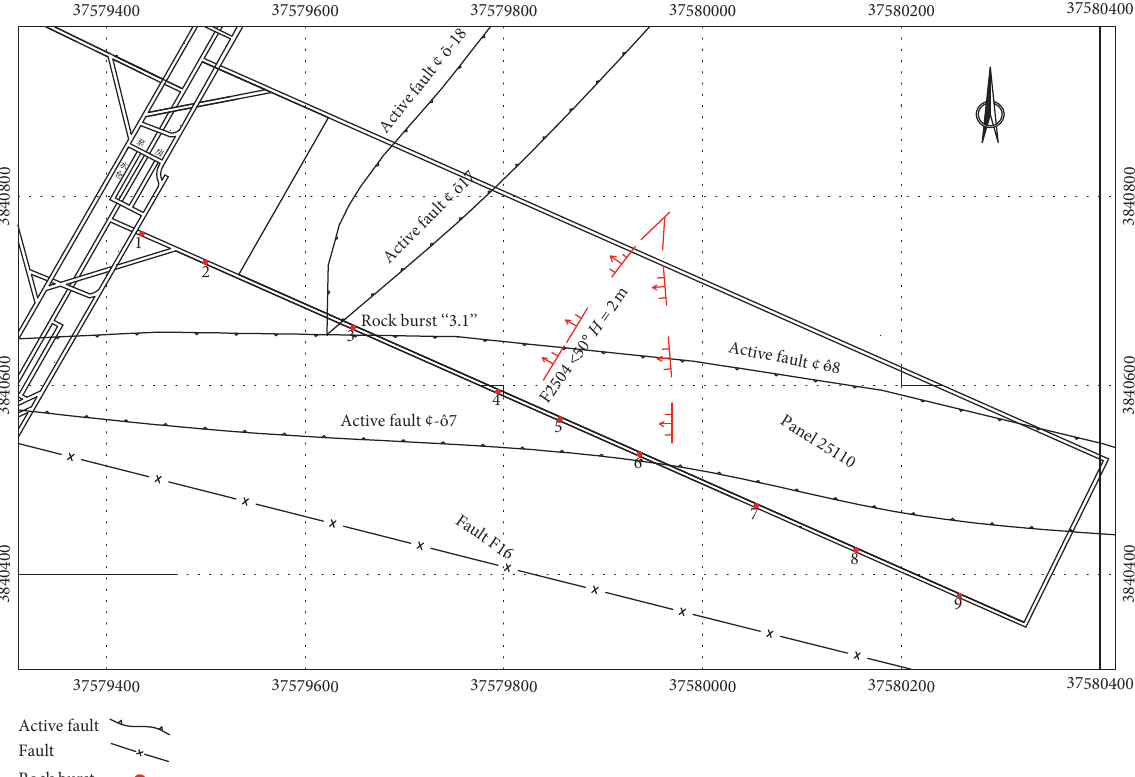
Figure 4: Positional relationship between 3.1 rock burst and fault structure in Yuejin Coal